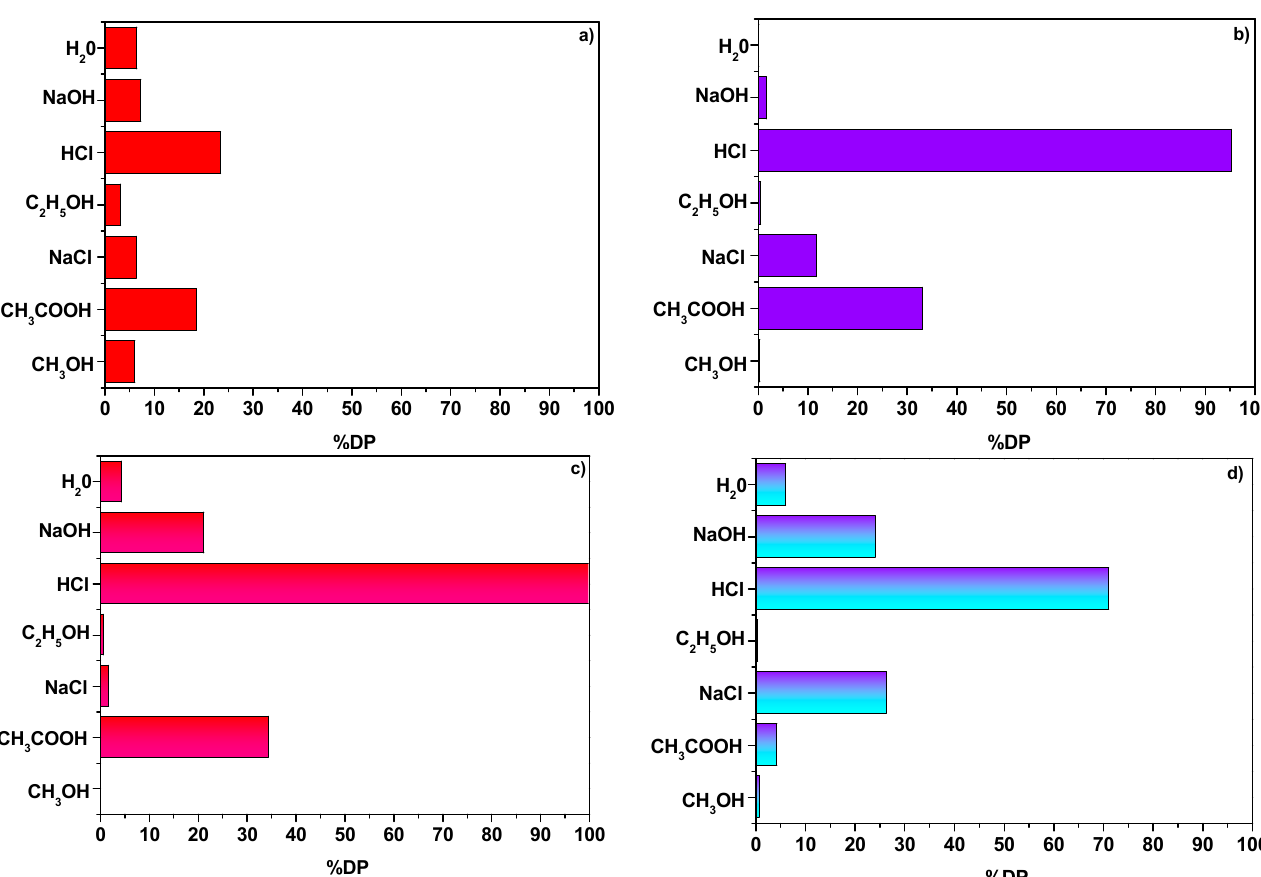
Figure 9. ( a ) Percentage of desorption DP(%) ( a ) AR18 and ( b ) Cu(II) from NaP1 a well as ( c ) AR18 and ( d ) Cu(II) from NaP1CS (m = 0.1 g, t = 120 min, A = 7, 180 rpm).